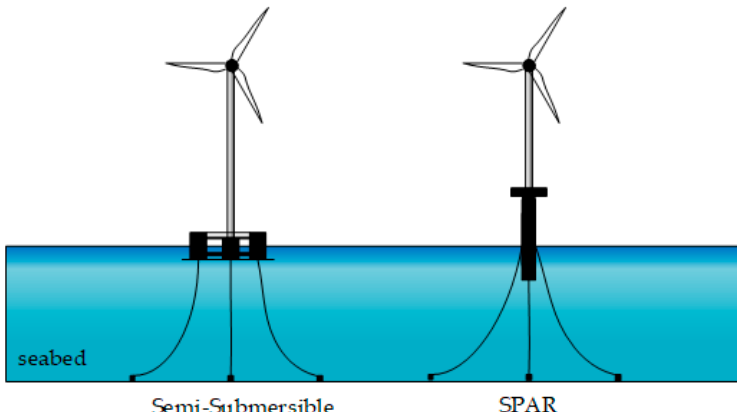
Figure 6. Floating wind turbine structures.